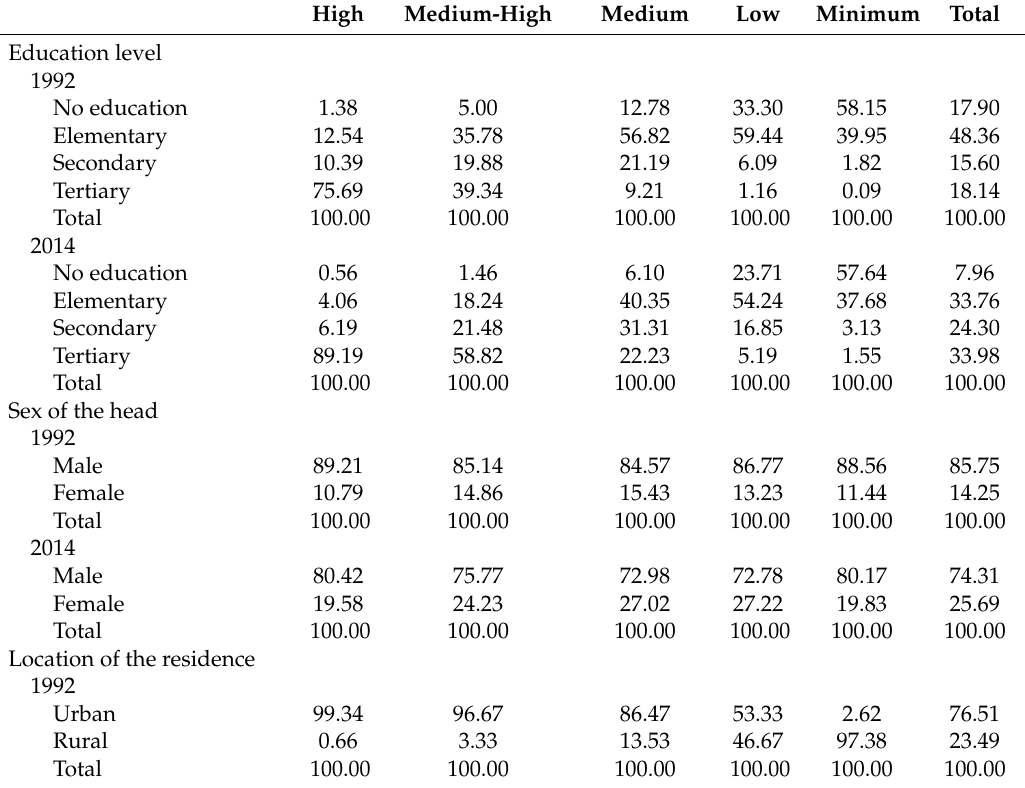
Table A6. Sociodemographic characteristics for consumer practices latent classes. M é xico 1992 and